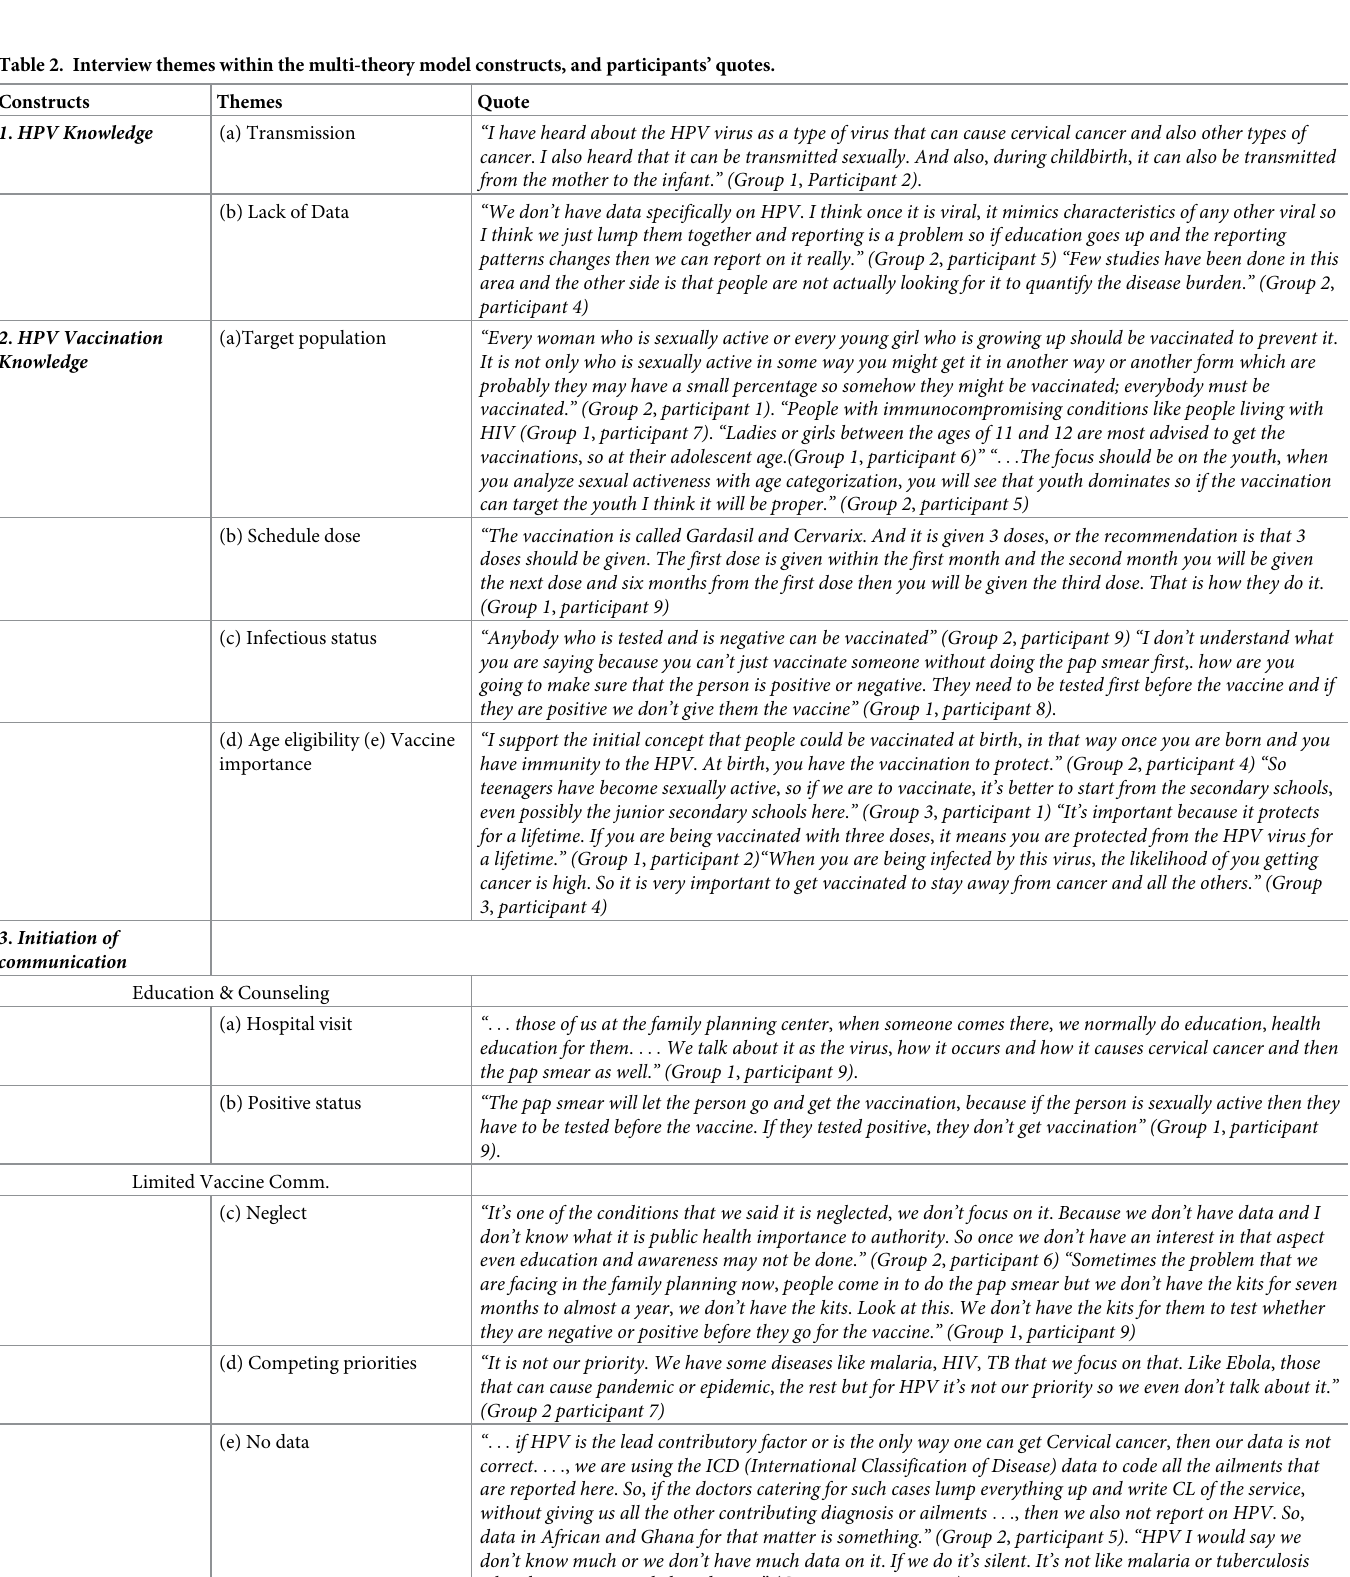
Table 2. Interview themes within the multi-theory model constructs, and participants’ quotes.